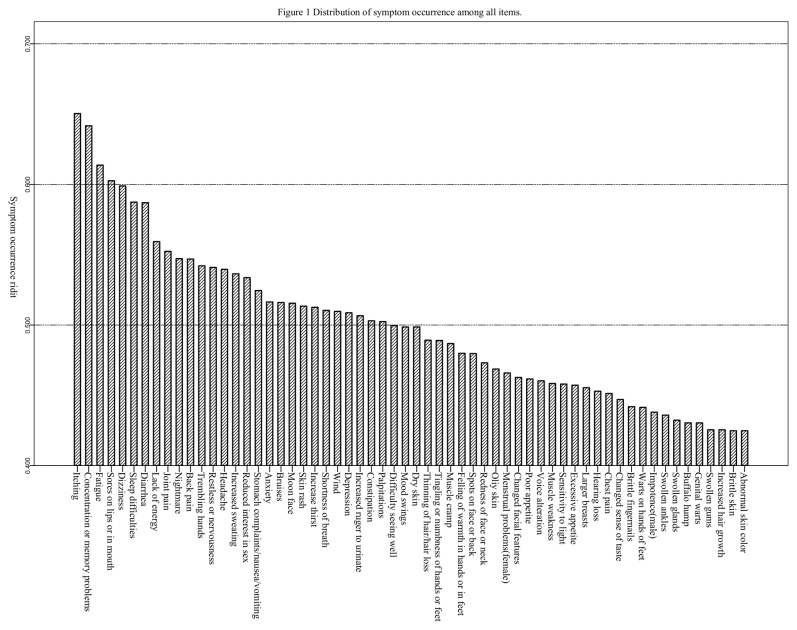
Distribution of symptom occurrence among all items.